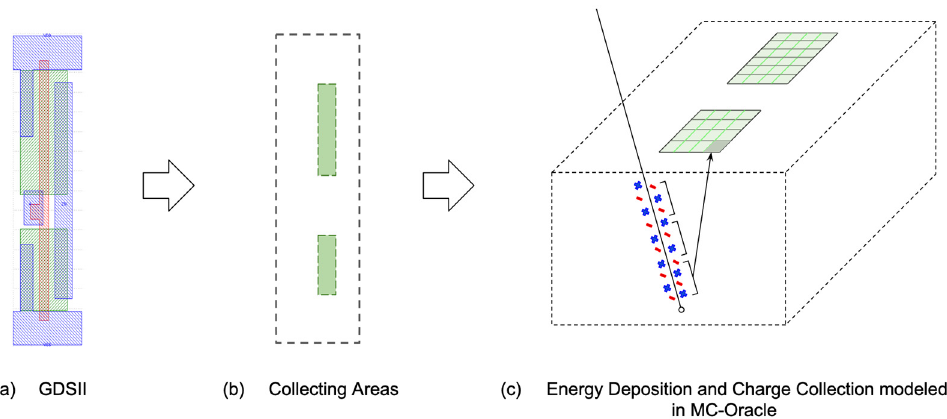
Figure 1. Representation of the extraction of the collecting areas from the circuit design (GDSII file) and the energy deposition and charge collection calculation in MC ‐